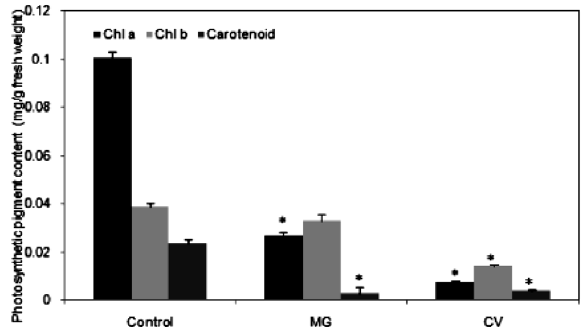
Fig. 6. The Lemna minor aquatic plant’s photosynthetic pigment from the control plants and after the phytoremediation experiments with triphenylmethane dyes (CV and MG); C 3 g (in fresh weight), V = 250 mL, pH = 3.5 (MG)/3.8 (CV), T = 23